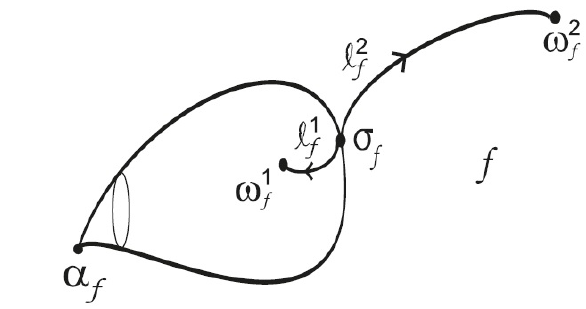
Fig. 1 The phase portrait of a diffeomorphism of class P